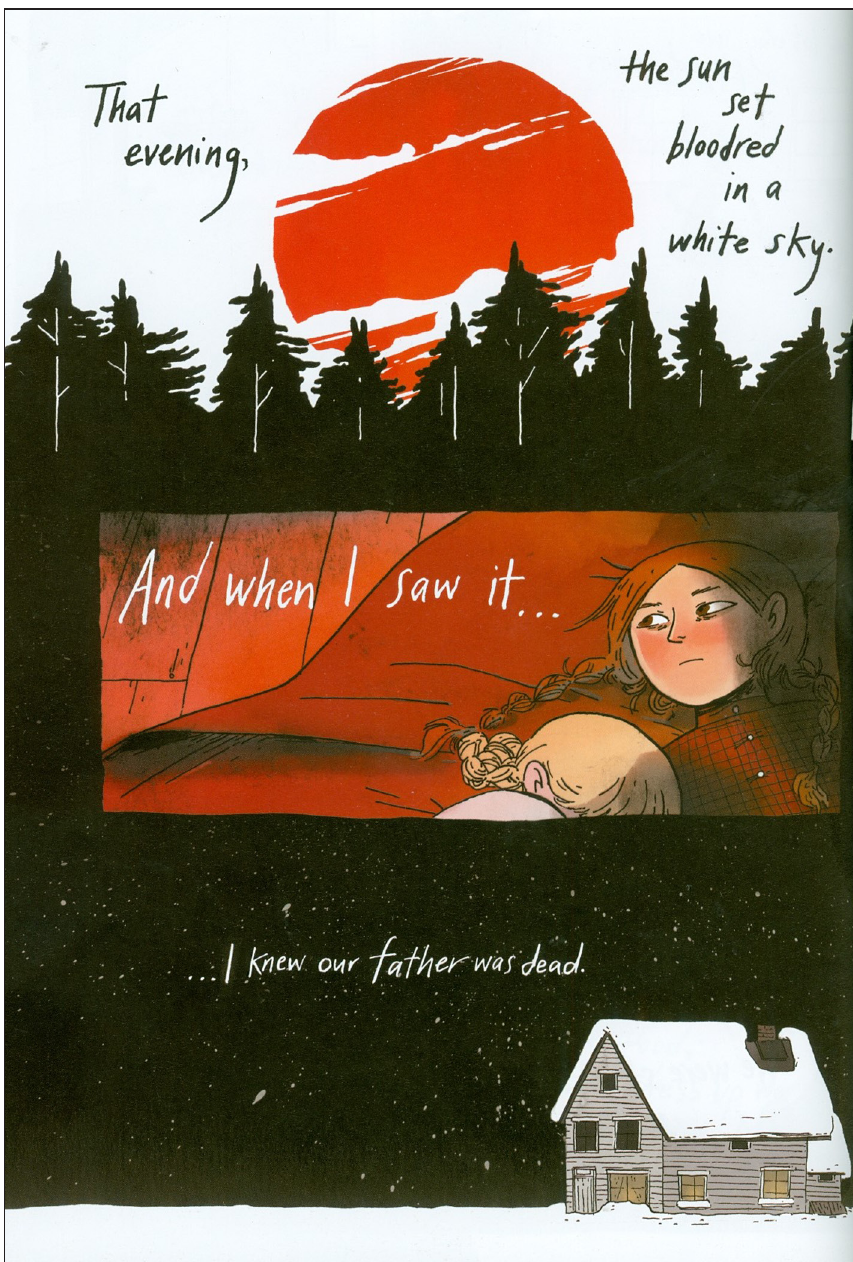
Figure 3: Carroll, E (2014). Through the Woods (New York: Faber & Faber, n.pag.) © Emily